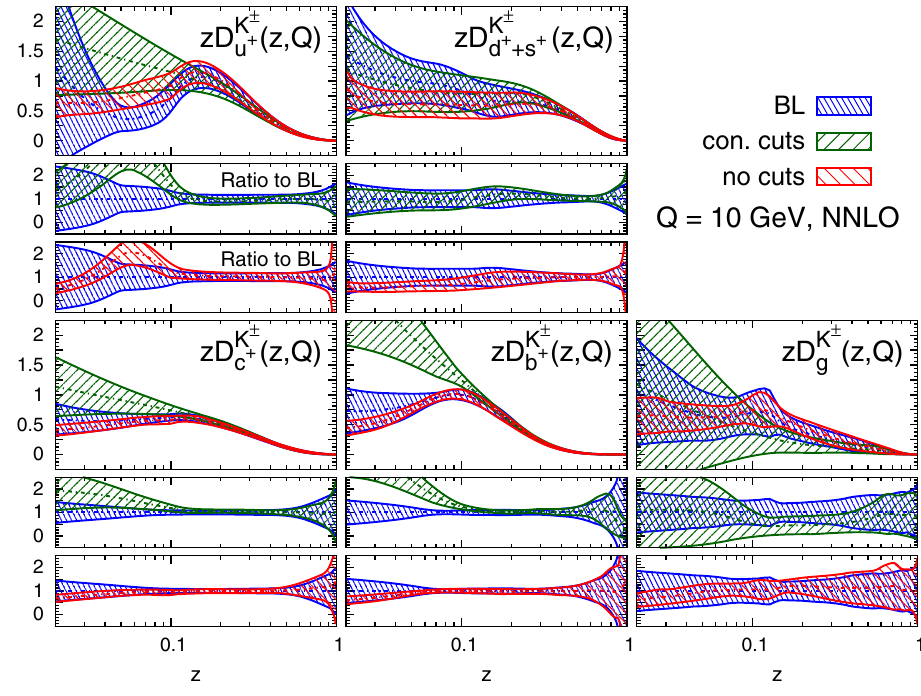
Fig. 18 Same as Fig. 17, but for the sum of charged kaons, K